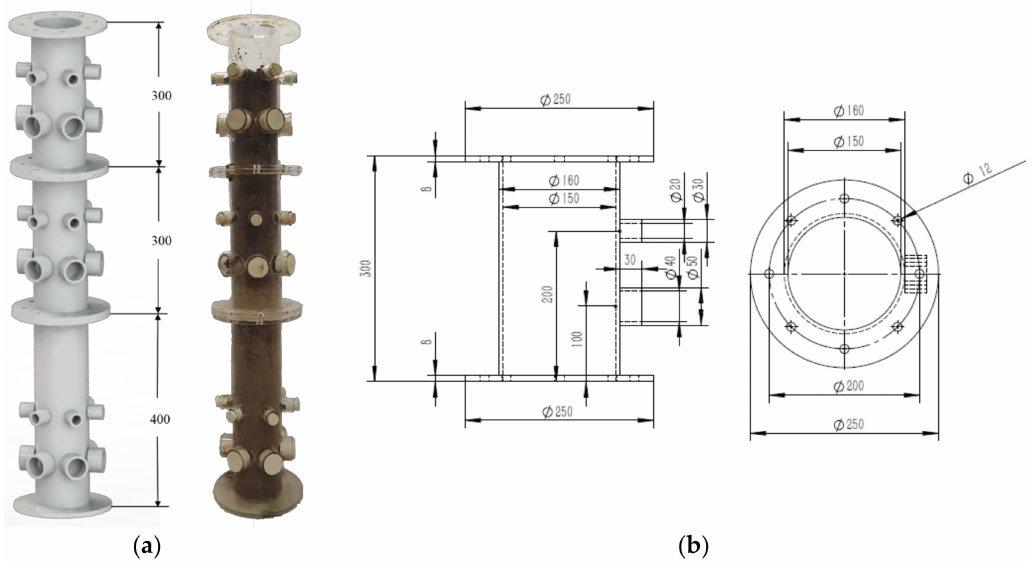
Figure 2. Diagram of the soil cylinder: ( a ) 3-stage design; ( b ) the drawing of the middle stage.